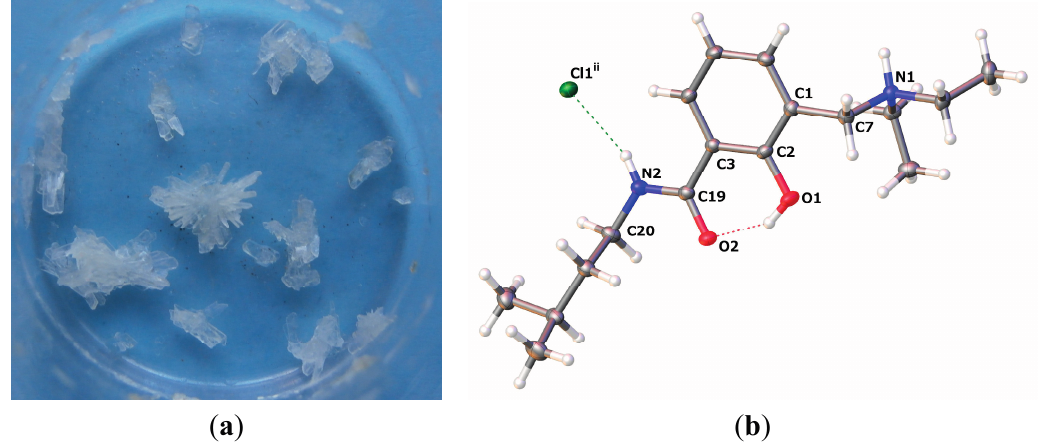
Figure 11. ( a ) Crystals grown for 14 ; ( b ) molecular structure of 14 (drawn at a 50% probability level; dashed lines: hydrogen bonding).